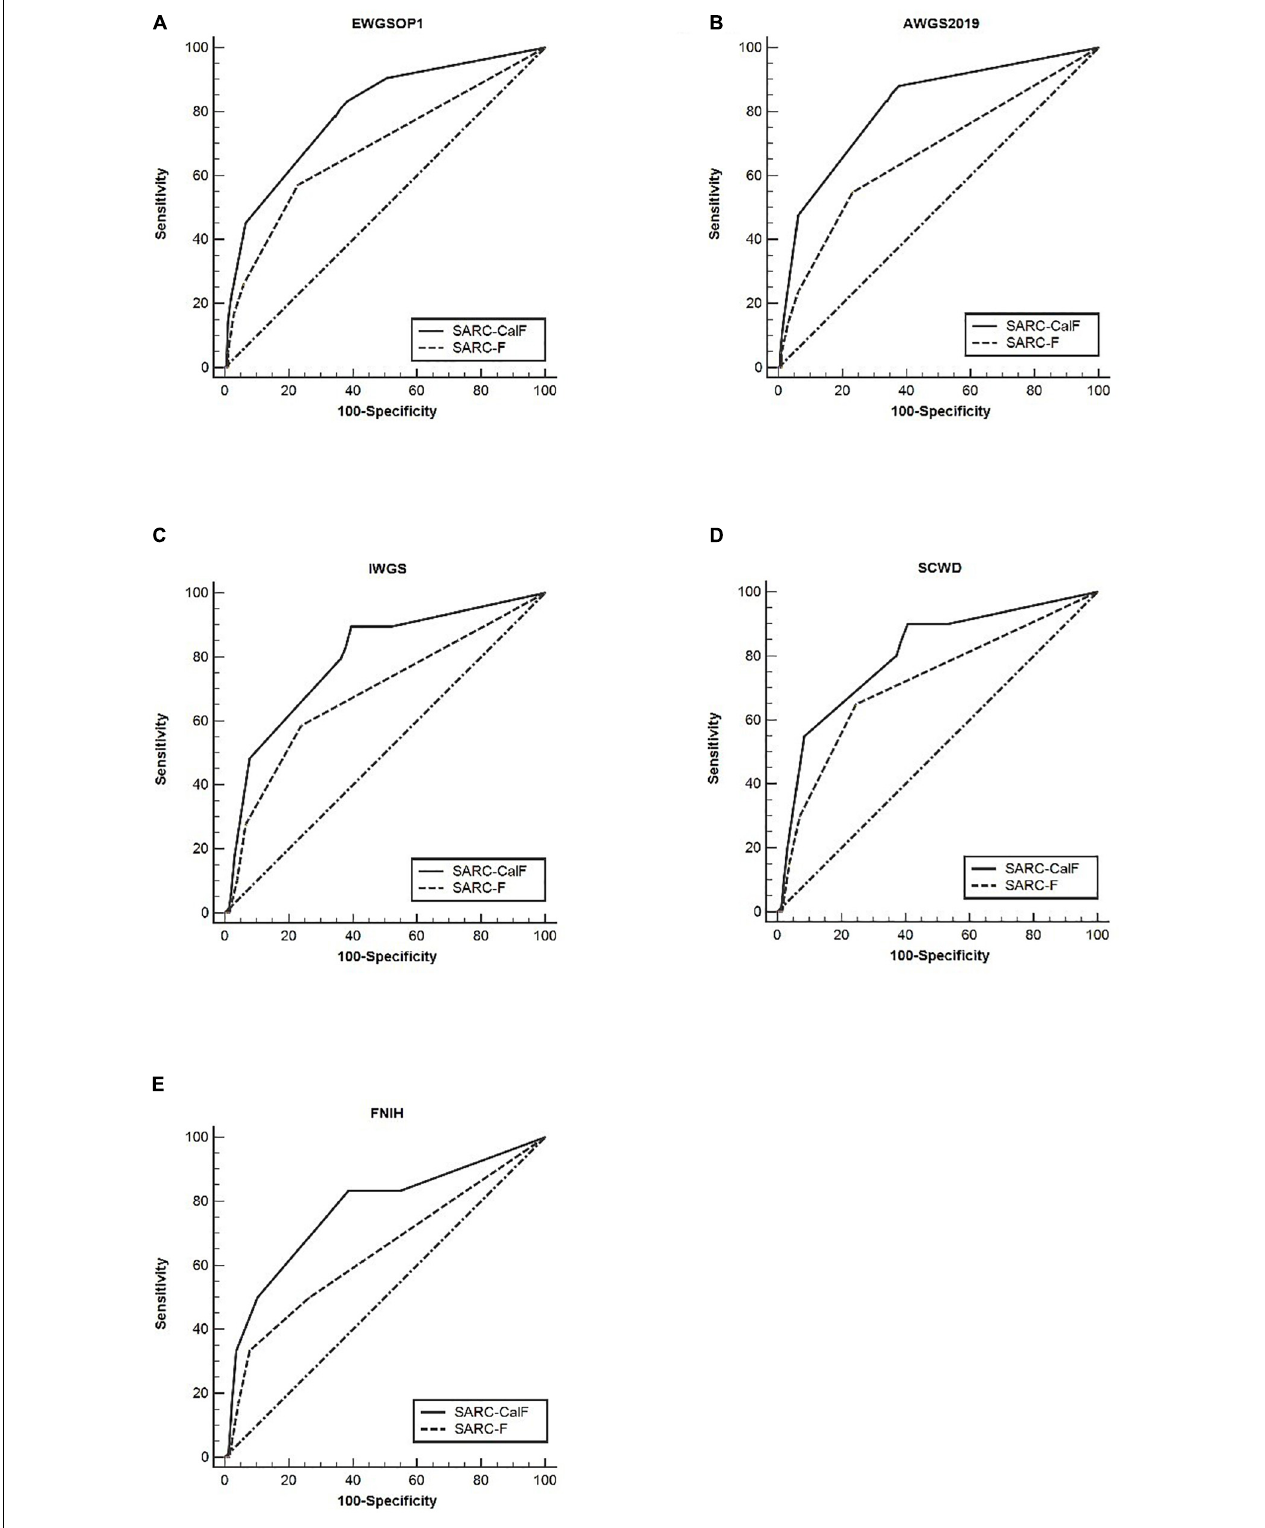
FIGURE 5 | The ROC curves of SARC-F and SARC-CalF compared with various reference standards in the category of younger subjects: (A) sarcopenia according to the EWGSOP1 criteria; (B) sarcopenia according to AWGS2019 criteria; (C) sarcopenia according to IWGS criteria; (D) sarcopenia according to SCWD criteria; and (E) sarcopenia according to FNIH